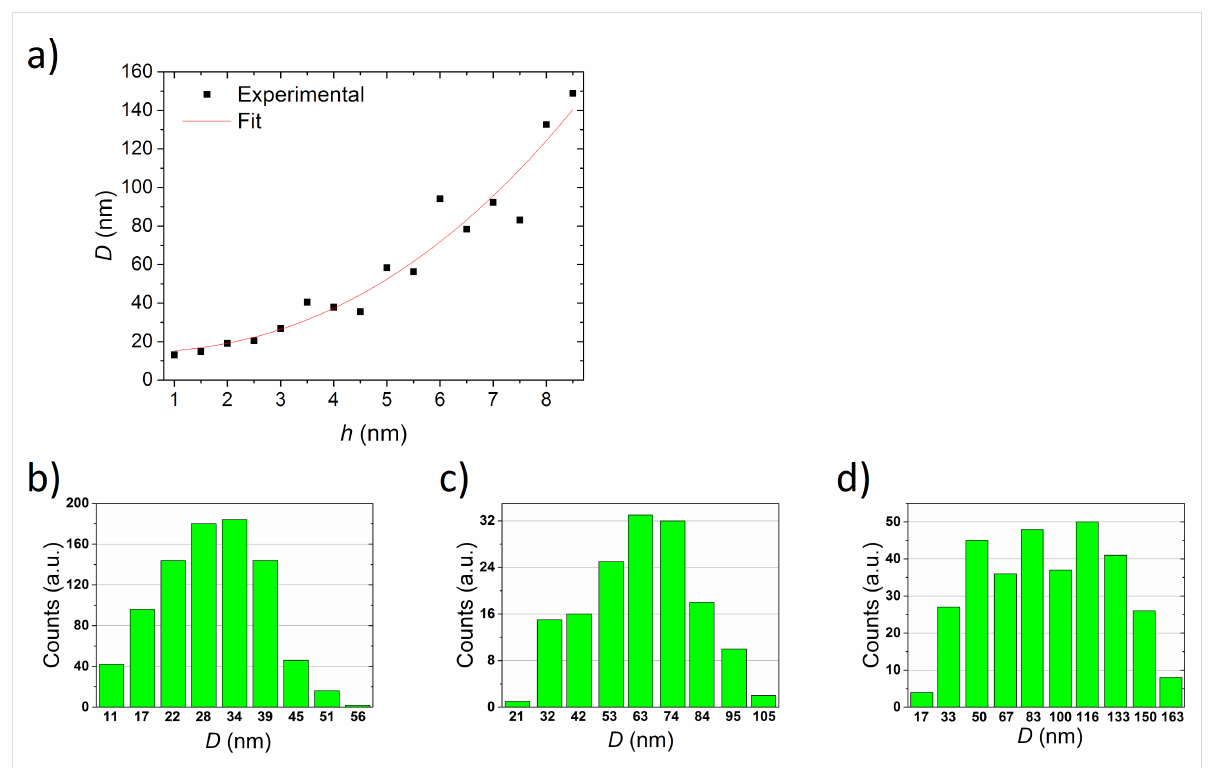
Figure 5: The dependence of the island diameter on the thickness of the initial film, calculated for Ag films annealed at 550 °C for (a) 15 min and the particle size histograms calculated for the nanoparticles obtained after annealing of films with an initial thickness of (b) 3 nm, (c) 5 nm and (d) 7